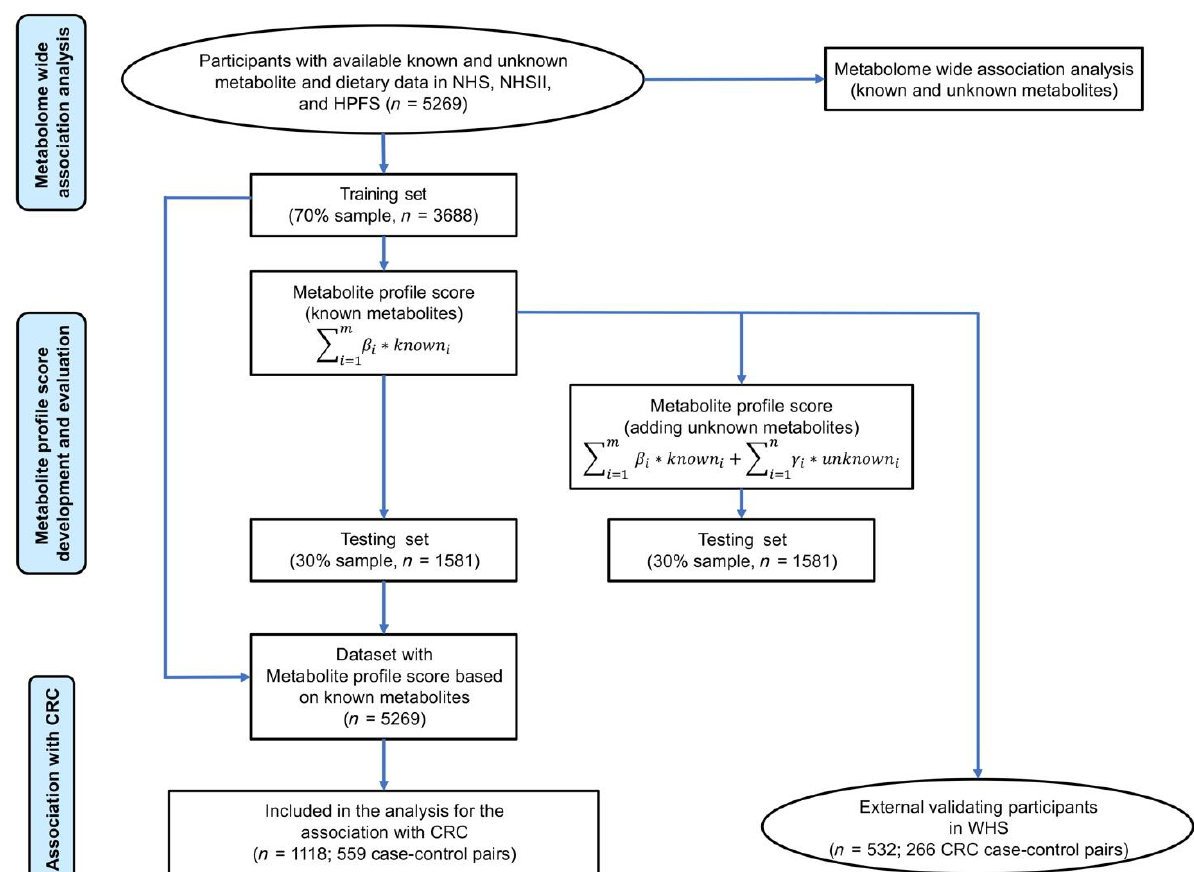
Figure 1. Schematic of the study design for the metabolome wide association analysis, development and evaluation of the metabolite profile scores, and analysis of CRC risk. CRC, colorectal cancer; HPFS, Health Professionals Follow-up Study; NHS, Nurses’ Health Study; NHSII, Nurses’ Health Study II; WHS, Women’s Health Study.